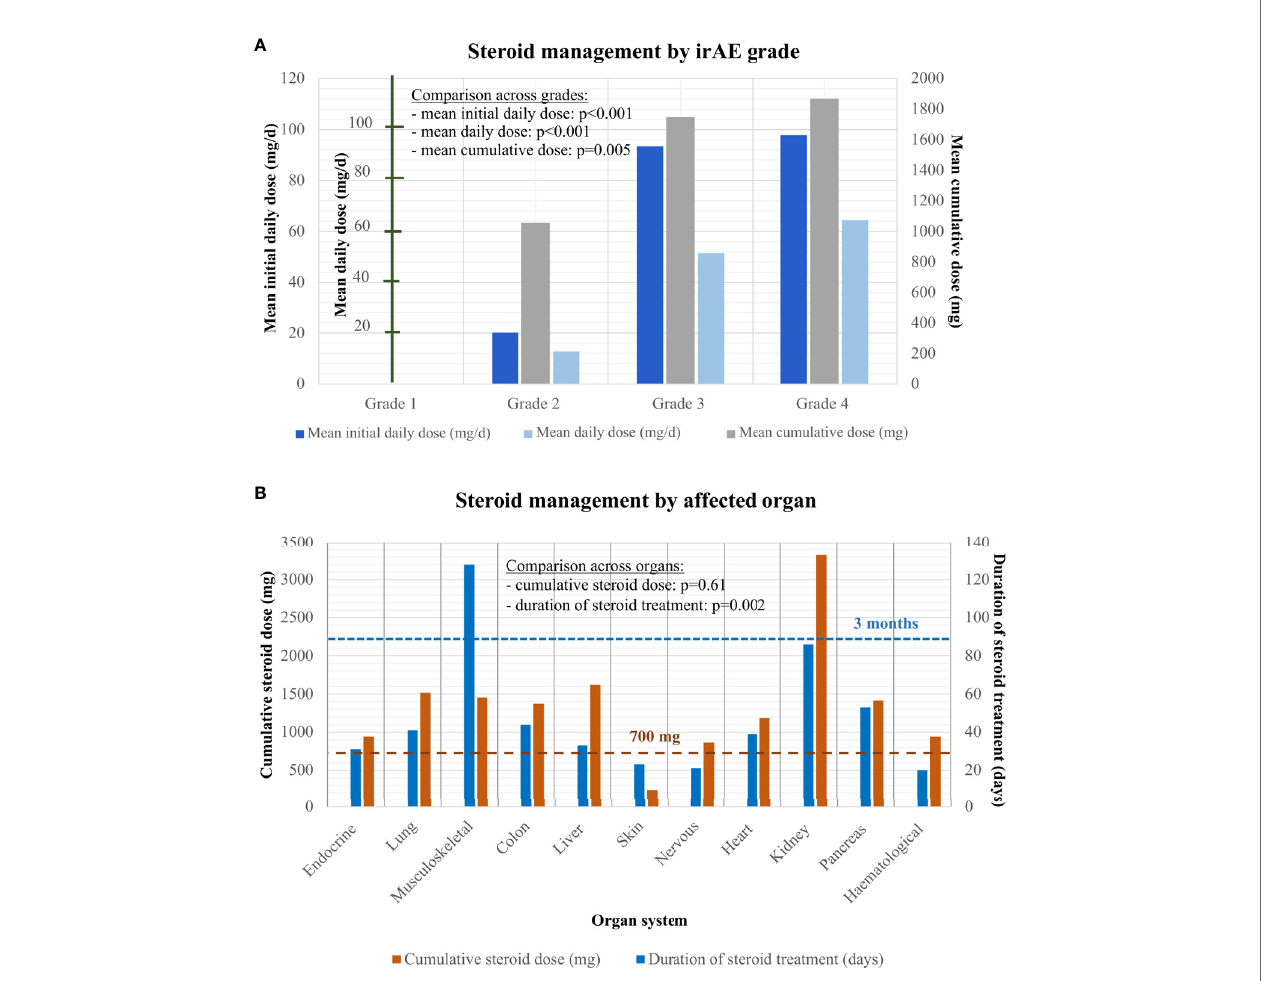
FIGURE 3 | Steroid management of grades 1 – 4 irAEs. (A) Mean initial daily dose, mean average daily dose, and mean cumulative dose for steroid treatment in patients with grade 2 – 4 irAEs analyzed by one-way ANOVA. While no grade 1 irAE received steroid treatment, mean initial daily, mean average daily and cumulative steroid dose increased steadily from grades 2 – 4: for grade 2 irAE mean initial dose: 20.2 mg [standard error (SE): 2.9], cumulative dose: 1056.4 mg (SE: 300.3), mean daily dose: 12.9 mg (SE: 2.0); for grade 3 irAE: mean initial dose: 93.4 mg (SE: 9.7), cumulative dose: 1747.5 mg (SE: 186.3), mean daily dose: 51.5 mg (SE: 5.3); for grade 4 irAE mean initial dose: 96.4 mg (SE: 10.9), cumulative dose: 1823.5 mg (SE: 348.4), mean daily dose: 62.8 mg (SE: 8.0). ANOVA with post-hoc test for trend across grades: p < 0.001 (mean initial daily dose), p < 0.001 (mean average daily dose), p = 0.005 (cumulative dose). (B) Cumulative steroid dose and total duration of steroid treatment by affected organ: endocrine: 942 mg (SE: 536) over 31 days (SE: 16); lungs: 1,519 mg (SE: 248) over 41 days (SE: 6)); musculoskeletal: mean cumulative dose 1455 mg (SE: 442) over 128 days (SE: 33); colon: 1,371 mg (SE: 227) over 44 days (SE: 7); liver: 1,622 mg (SE: 339) over 33 days (SE: 5); skin: 237 mg (SE: 123) over 23 days (SE: 11); nervous system: 863 mg (SE: 427) over 21 days (SE: 9); cardiologic: 1,183 mg (SE: 684) over 39 days (SE: 31); kidney: 3,330 (SE: 2,394) over 86 days (SE: 9); pancreas: 1,413 mg (SE: 1035) over 53 days (SE: 5); blood: 940 mg (SE: na) over 20 days (SE: na). One-way ANOVA p = 0.002 for the cumulative dose across affected organs (with statistical signi fi cance in post-hoc testing for musculoskeletal irAE, please see Table 2 ), and p = 0.61 for the treatment duration. Abbreviations: irAEs, immune related adverse events; SE, standard error of the mean; n/a, not